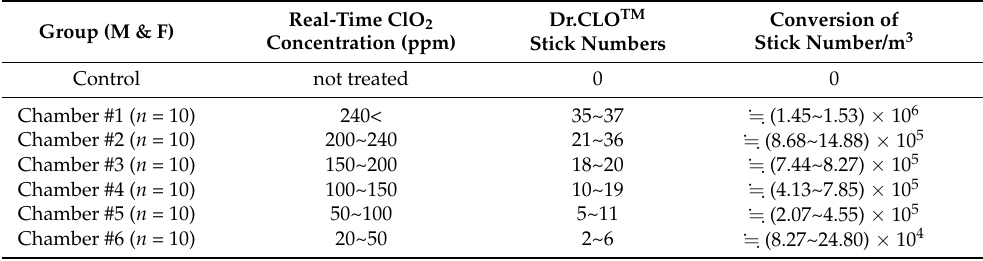
Table 1. Group composition by ClO 2 gas concentration, real-time concentration of ClO 2 gas, number of applied Dr.CLO TM sticks, and conversion value of ClO 2 gas concentration per cubic meter. Real-Time ClO 2 Dr.CLO TM Group (M & F) Concentration (ppm) Stick